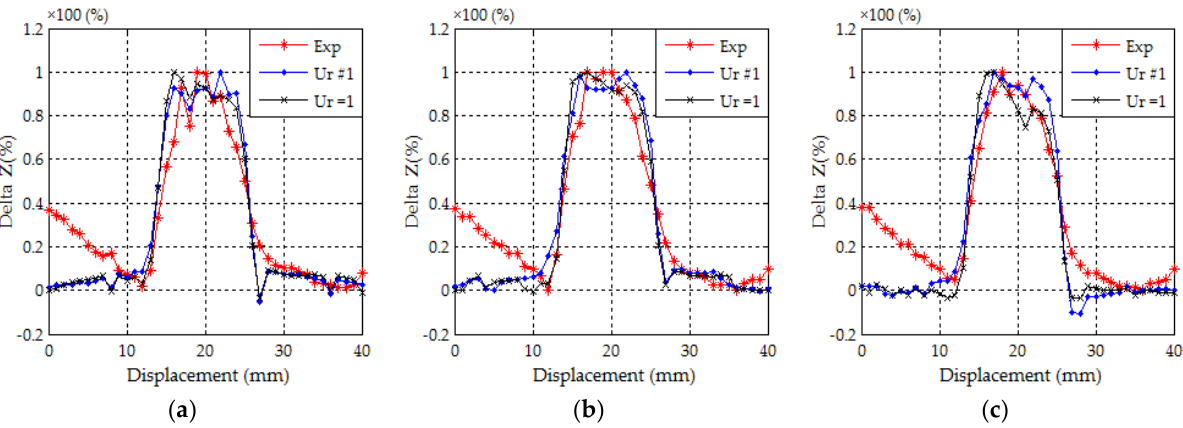
Figure 12. Impedance variation in (%) at 100 kHz with ( a ) depth = 0.3 mm, ( b ) depth = 0.5 mm, and ( c ) depth = 1 mm.